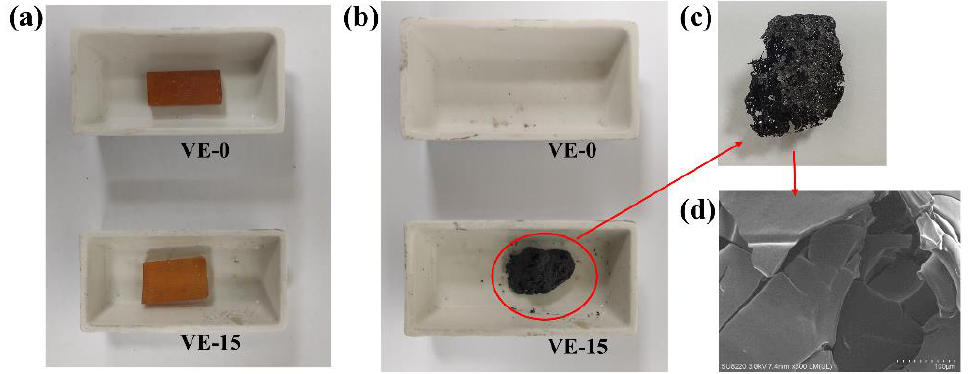
Figure 8. Digital photographs of VE-0 and VE-15 composites ( a ) before and ( b ) after being heated at 650 °C in air; ( c ) Photograph of char carbon of VE-15; ( d ) SEM of the char carbon of VE-15.